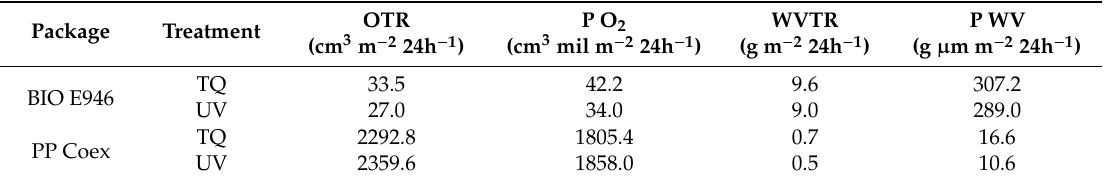
Table 4. Oxygen and water vapor transmission rates and permeations of BIO E946 and PP Coex films, UV treated and not